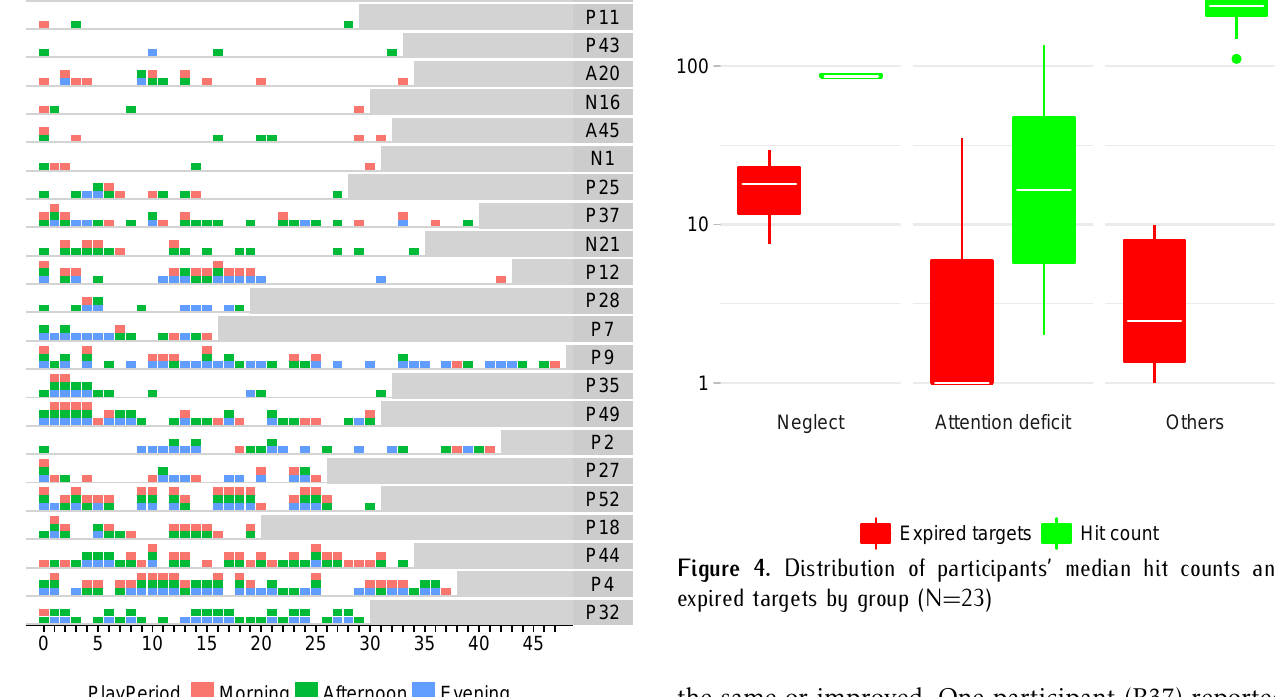
the same or improved. One participant (P37) reported due to any perceived or assumed health